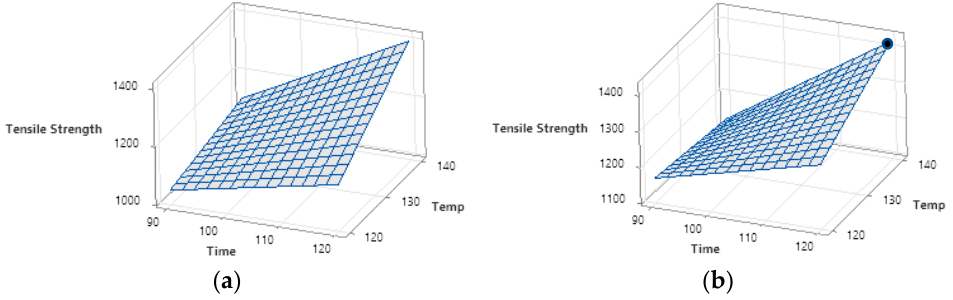
Figure 9. Surface plots of the tensile strength ( TS ) at a constant pressure of ( a ) 3 bar; ( b ) 7 bar. TS was observed to increase with temperature, time, and pressure. The optimum tensile strength was observed at CC8 (140 °C, 120 min, and 7 bar), represented by a black dot. Table 6. A comparative summary of non-optimum and optimum properties. This table compares MRCC (non-optimal) curing parameters and non-optimum properties with optimal curing param- eters and optimum properties.